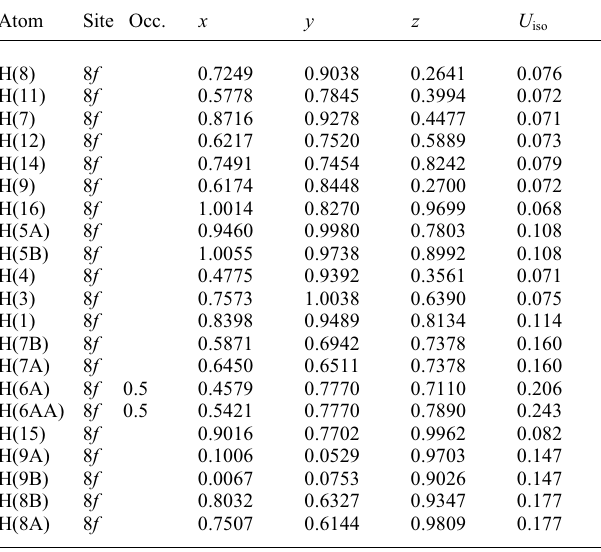
Table 1. Data collection and handling.